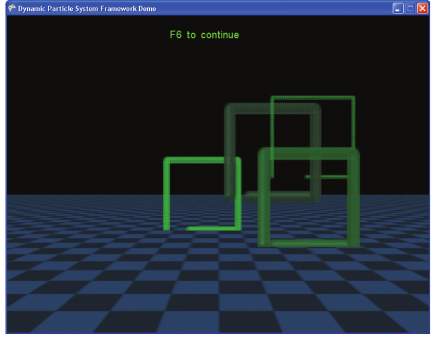
Figure 3: Particles traveling in square